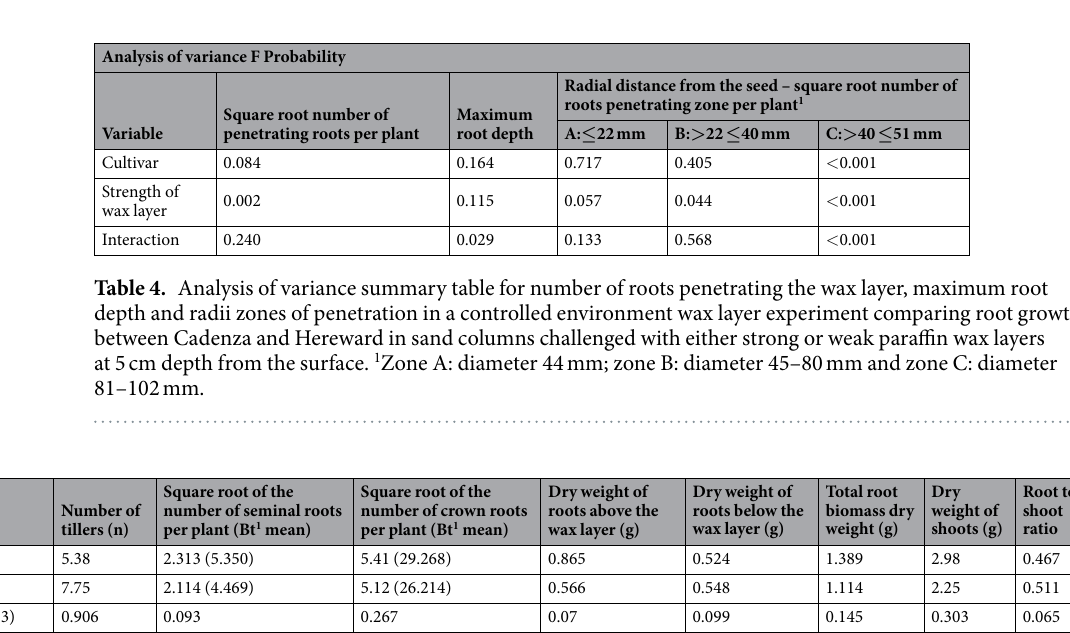
Table 3. First wheat root phenotyping study for the low TAB cultivar Cadenza compared to the high TAB cultivar Hereward in two field seasons (2009–2010 and 2014–2015). 1 Bt = Back-transformed.